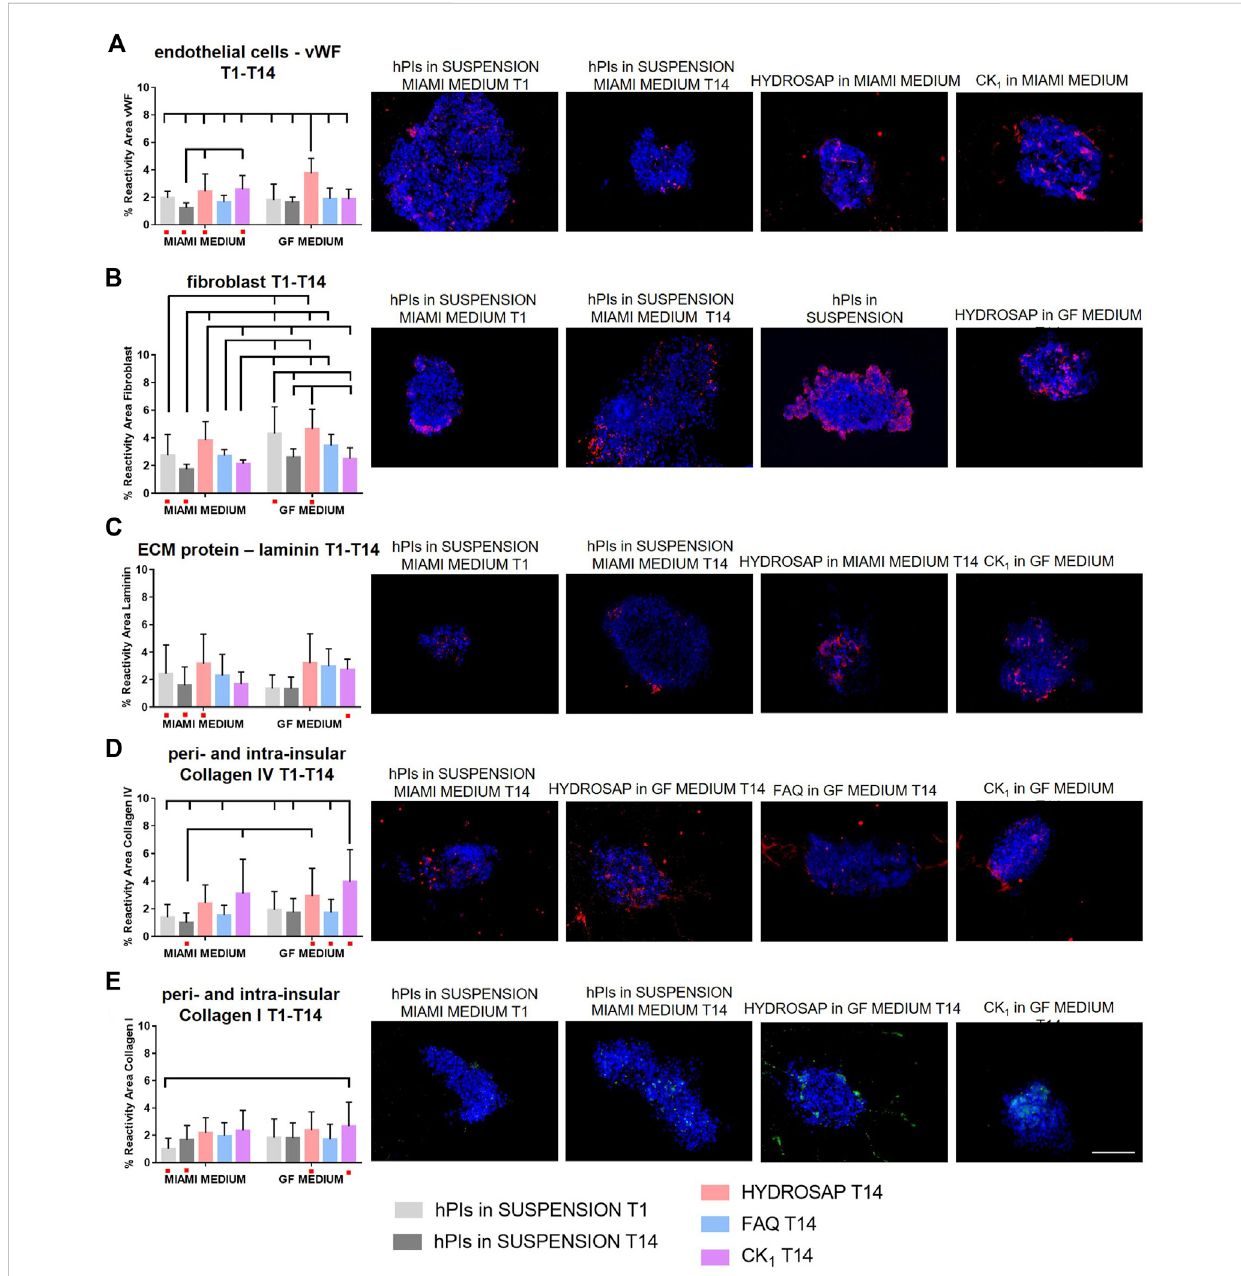
FIGURE 3 CharacterizationofmainECMcomponents, fi broblastcellsandendothelialcellsinhPIsat14 days invitro inHYDROSAP,FAQandCK 1 scaffoldsorin suspensioninMIAMI orGFmedia. Fresh-isolatedhPIs(T1)wereconsideredaspositivecontrol,whilehPIsinsuspensionfor14-daysinMIAMI orGFmedia asnegativecontrols.Graphsandrelatedimagesshowpercentageofreactivityareafor (A) vWFinred, (B) fi broblastinred, (C) laminininred, (D) collagenIV in red, and (E) collagen I in green, showing a stable expression in HYDROSAP scaffold (with no signi fi cant differences between culture media) for all these markers. Cell nuclei are stained in blue. Images illustrate islets in selected culture conditions, depicted in each graph with a red dot. Data are presented as mean ± SD, two-way ANOVA with Tukey post hoc test: statistical differences were evaluated among all groups and speci fi ed in Supplementary Table S3 ( n = 3; * p < 0.05 ; ** p < 0.01 ; *** p < 0.001 ). Scale bar, 100